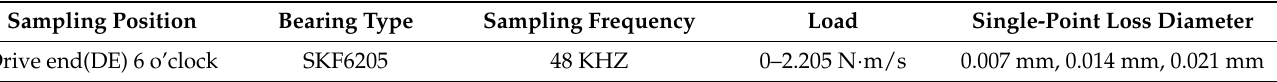
Table 1. CWRU bearing open data set sample processing.